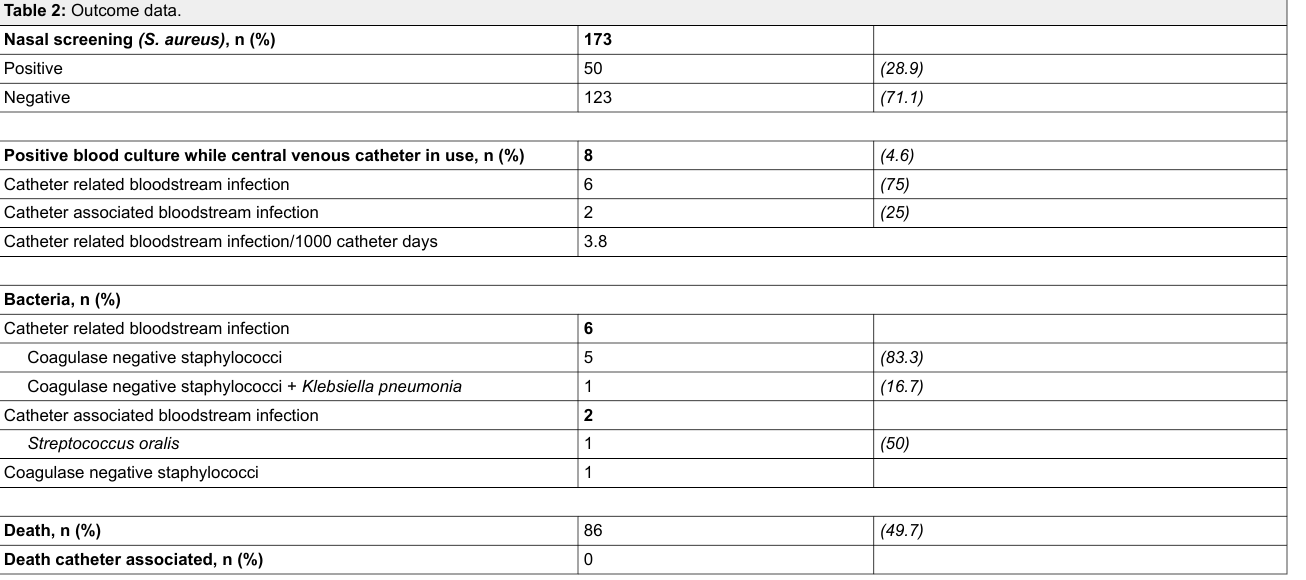
Table 2: Outcome